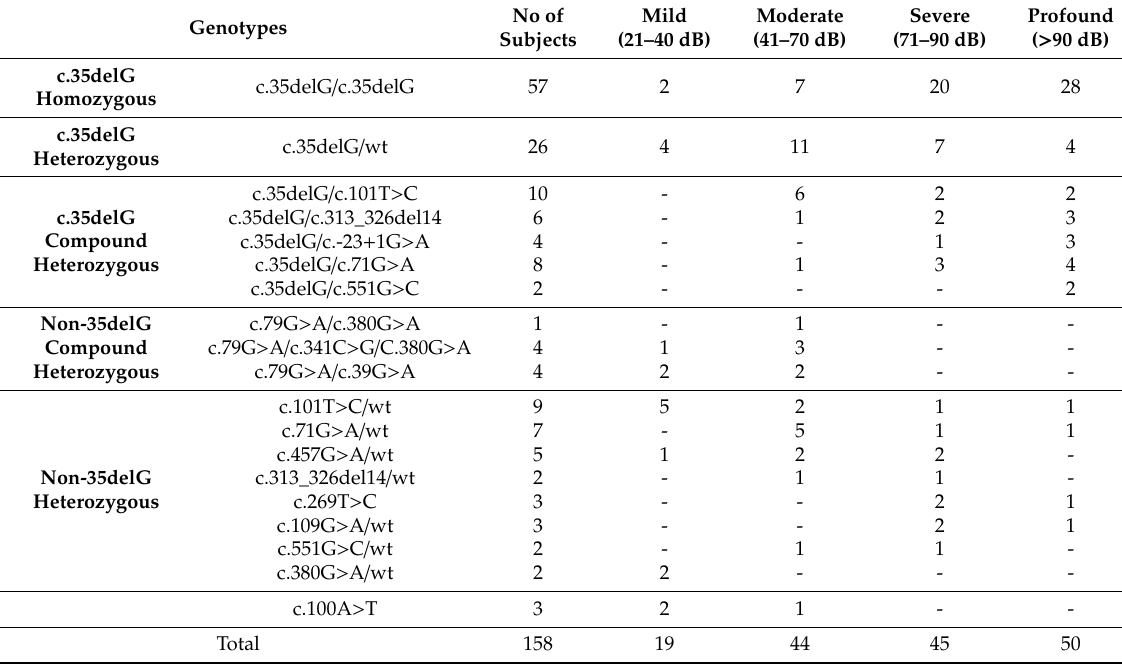
Table 2. Correlations of GJB2 genotypes and severity of hearing